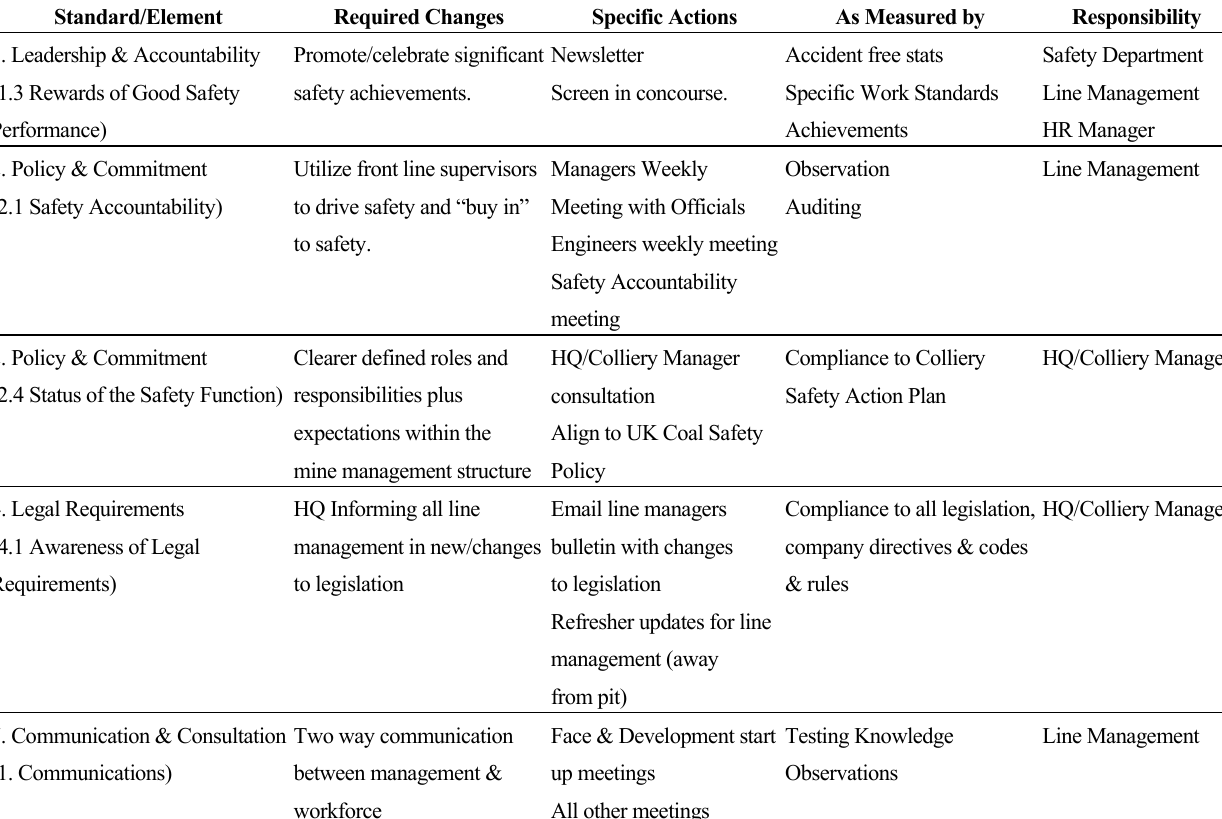
Table 5. Action plan from Mine